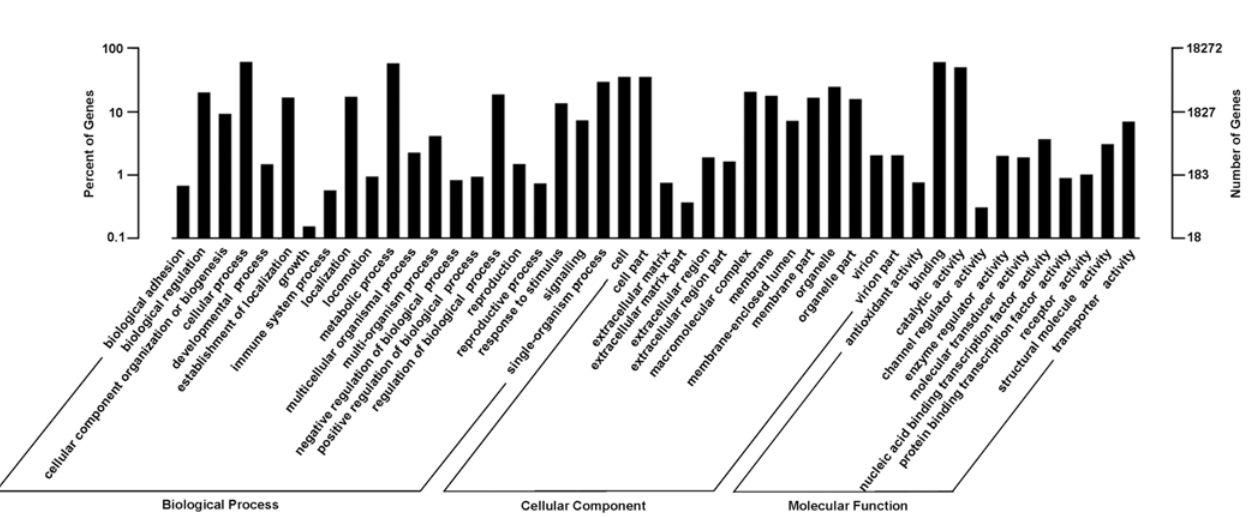
Fig 4. GO categories of biological process, cellular component and molecular function for the transcriptome of the A . sparsifolia primary roots. The right y-axis shows the number of genes in a category, and the left y-axis indicates the percentage of a specific category of genes in that main category. doi:10.1371/journal.pone.0120791.g004 PLOS ONE | DOI:10.1371/journal.pone.0120791 March 30,